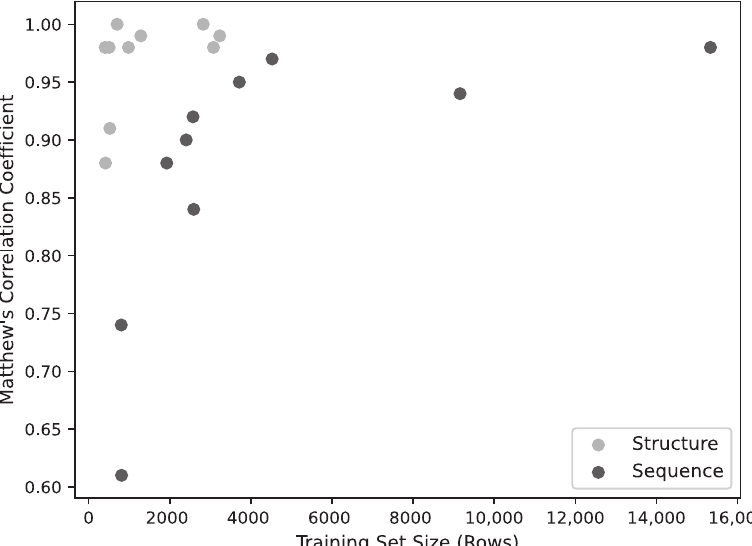
Figure 2. Model Performance (MCC) as a function of training set size. Below ∼ 4000 training patterns, performance declines sharply, though above this threshold there ceases to be a strong correlation between performance and training set size.